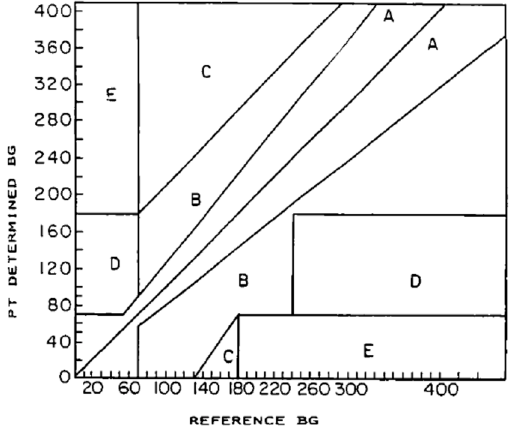
Figure 2. Clarke error grid. Reproduced with permission [22]. Copyright 1988, Elsevier.